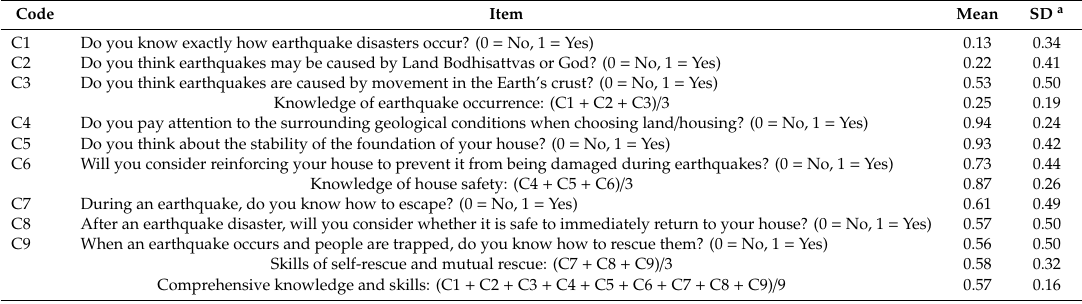
Table 3. The entries related to knowledge and reported skills of earthquake